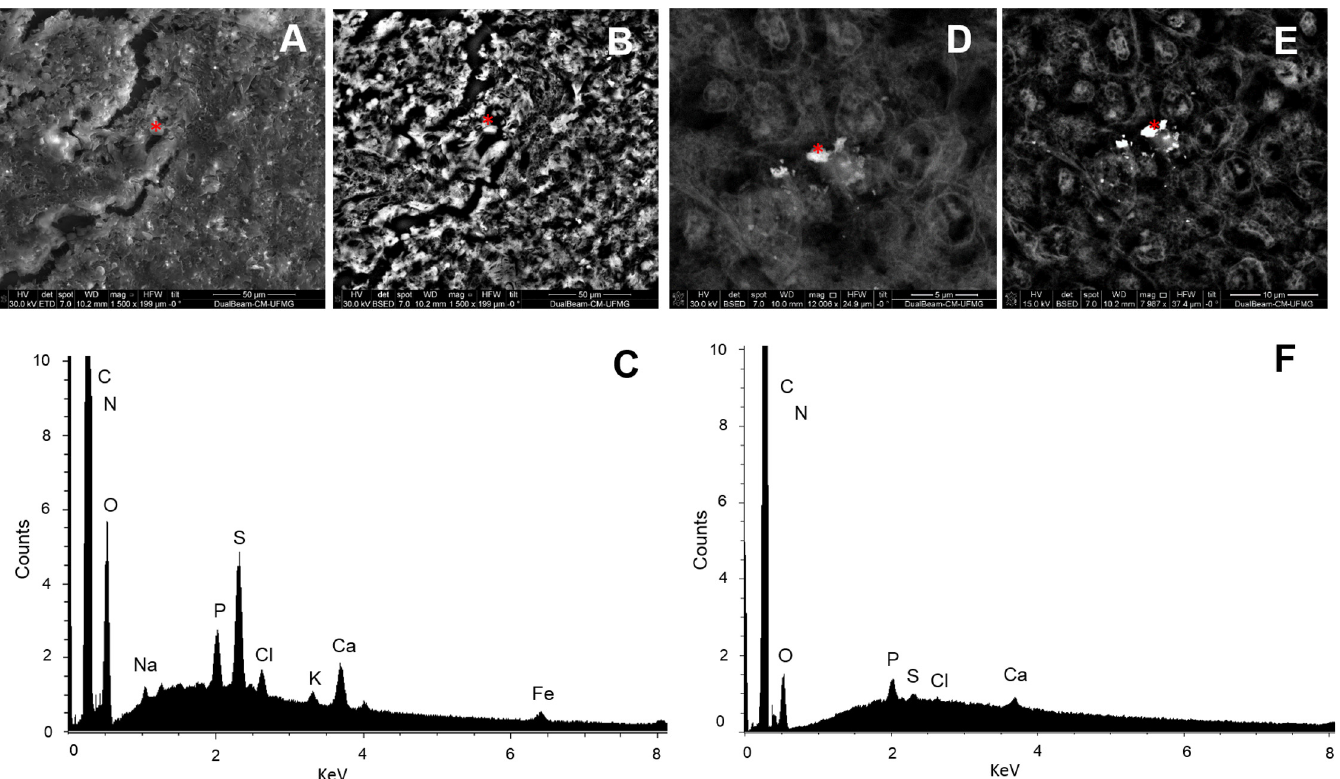
Fig 10. Spleen and head kidney MMCs. (A) Surface images obtained by secondary electrons from spleen and (D) head kidney tissue sections. The corresponding backscattered electron images of electron-dense granules from the red dots were identified in the respective images (B, E). The spectra obtained by X-ray microanalysis of the granule in spleen (C) and head kidney (F), showing characteristics peaks of C, O, P, S, Ca and Fe and C, O, P, S and Ca, respectively.